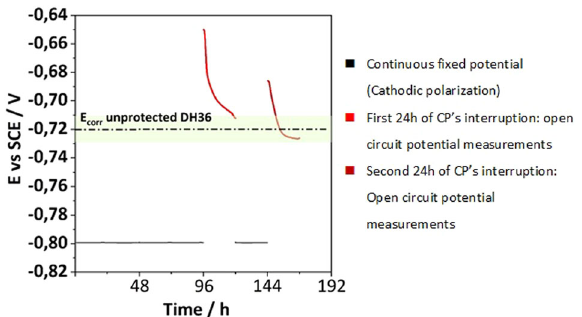
Fig. 15 Monitoring of the potential at the DH36 surface under on/ off period of cathodic protection. Potential ate DH36 surface in the function of the time, at 20 °C, static conditions and in natural aeration